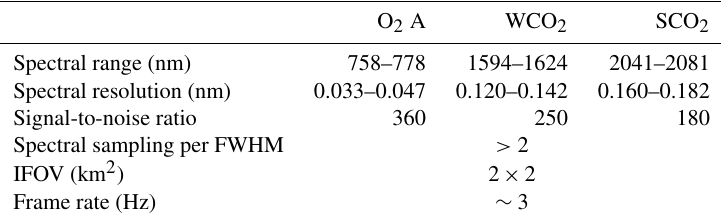
Table 1. Summary of the ACGS spectral requirements.